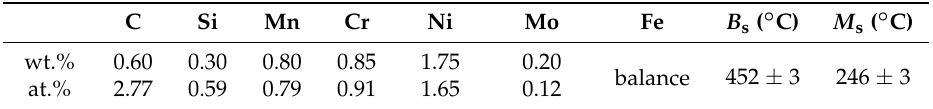
Table 1. Chemical composition and measured characteristic temperatures of the investigated steel used in this study. B s (bainitic start temperature) and M s (martensitic start